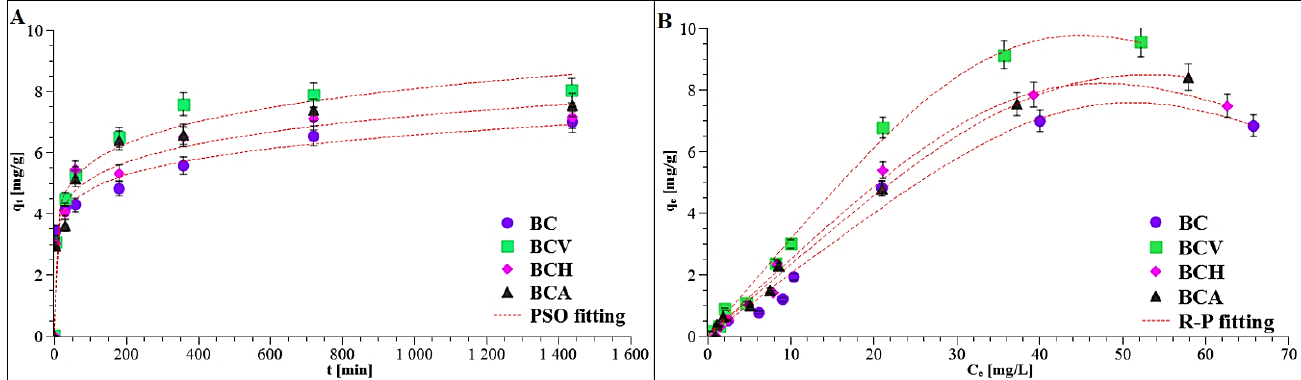
Figure 5. Adsorption kinetics ( A ) and isotherms ( B ) of TC on modified and non-modified biochars.